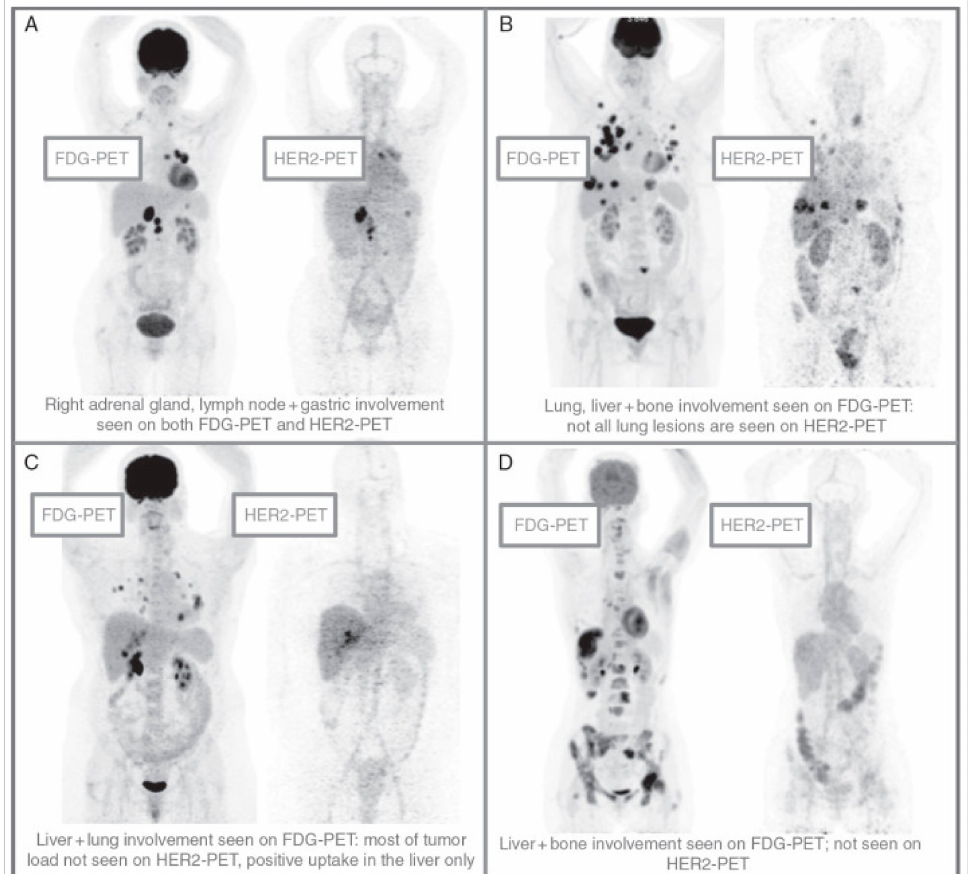
Figure 4. Patterns of HER2–PET/CT compared with FDG–PET/CT, Maximum intensity projection. Lesion uptake was considered concerning for malignant disease when visually higher than blood pool. ( A ) Entire tumor burden showed concerning tracer uptake; ( B ) Major portion of the tumor burden showed concerning tracer uptake; ( C ) A very small subset of the tumor burden showed concerning tracer uptake; ( D ) The entire visualized tumor burden lacked concerning tracer uptake. Adapted from